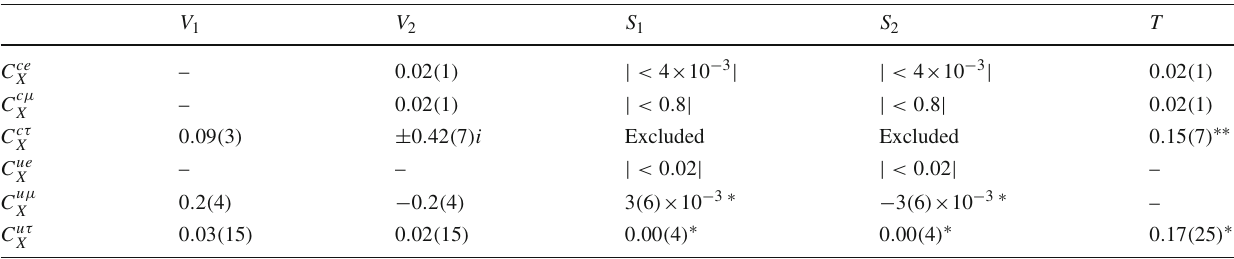
Table 1 Status of applicable flavor bounds. “ | < n | ” means | C X | < n , c μ where those for C ce are the bounds from the theoretical estimates S 1 , 2 whereas that for C ue is obtained from the 90% CL upper limit. The S 1 , 2